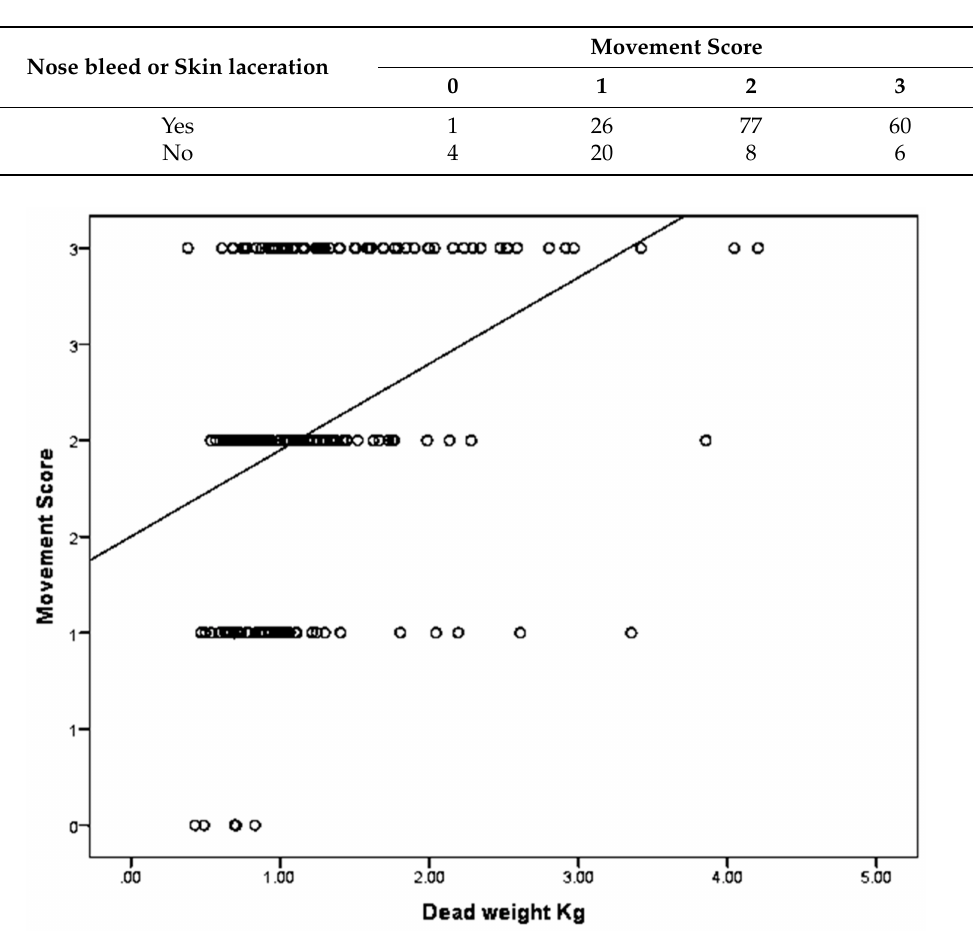
Figure 10. The relationship between piglet dead weight and movement score, where Score 0 = very little movement; Score 1 = some mild uncontrolled physical movement of limbs; Score 2 = considerable uncontrolled physical movement of limbs; and Score 3 = gross uncontrolled physical movement. N =